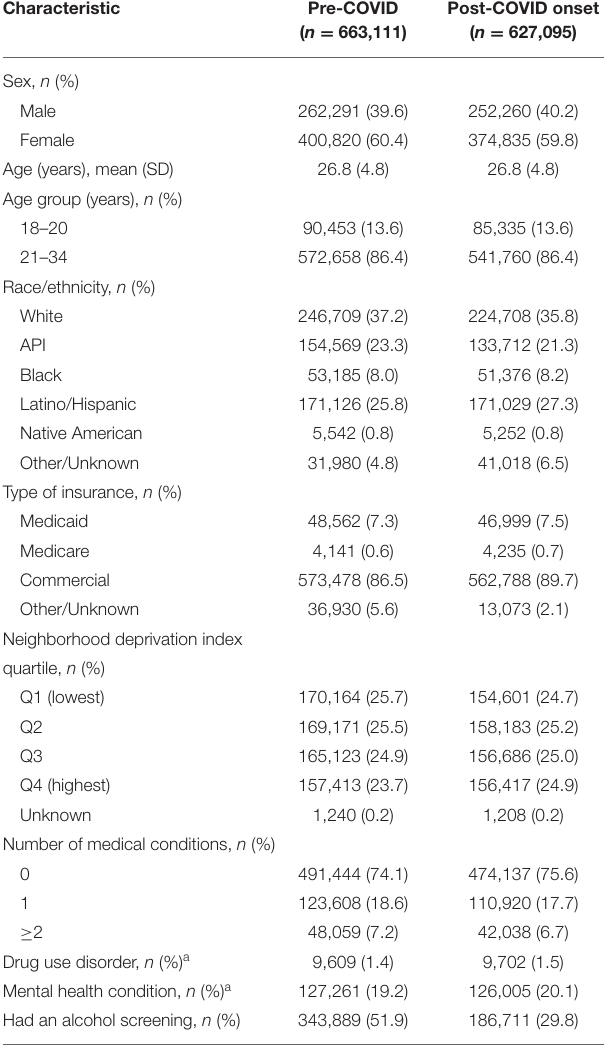
TABLE 1 | Characteristics of young adult (18–34 years) KPNC members who utilized primary care pre-COVID (March to December 2019) and post-COVID onset (March to December